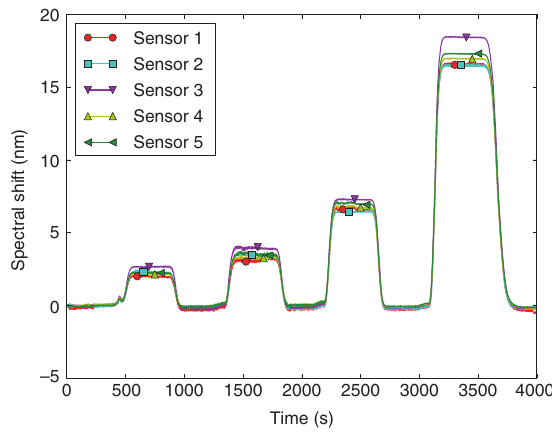
Figure 10: Sensorgram of parallel measurement of five MZI sensors, where the sensors are exposed to different concentrations of HCl in alternation with